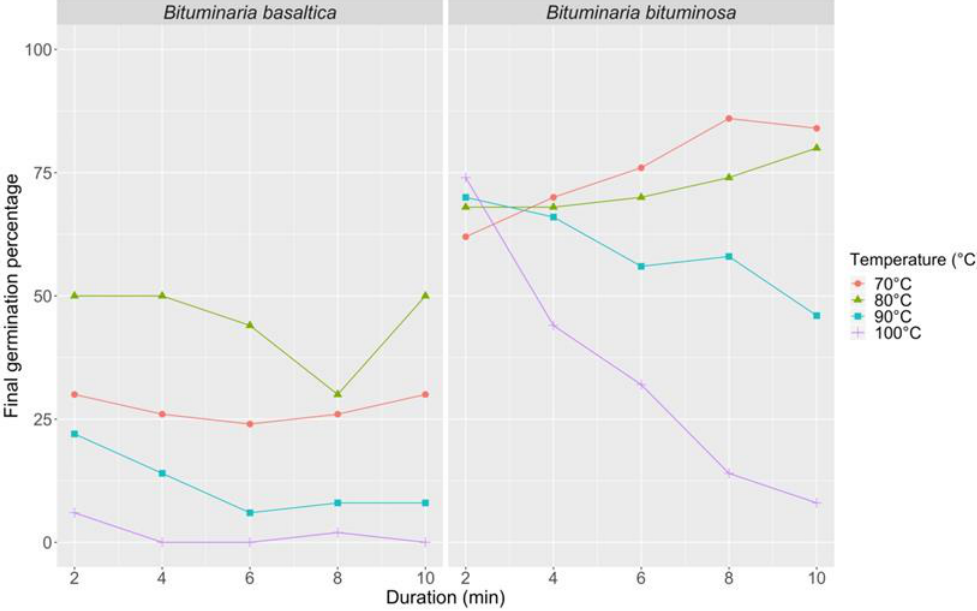
Figure 5. Final germination percentage at 25/20 °C incubation temperature in B. basaltica and B. bituminosa after different immersion times (2, 4, 6, 8, 10 min treatment duration) in hot constant water (70, 80, 90, and 100 °C).